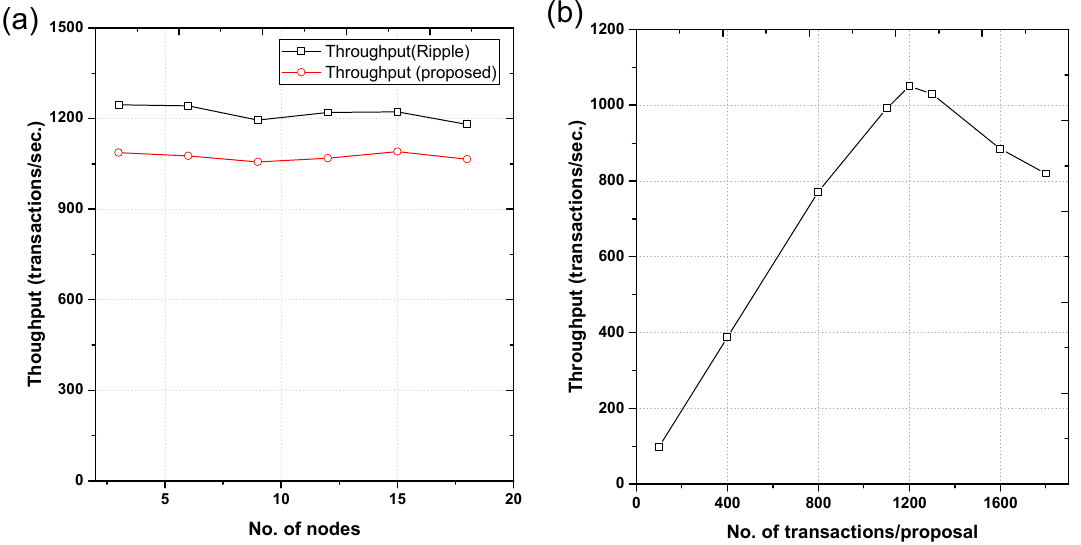
Figure 5. ( a ) Throughput of the proposed blockchain distributed network in comparison to Ripple, and ( b ) Throughput of proposed blockchain architecture for 15 nodes to check the scalability.